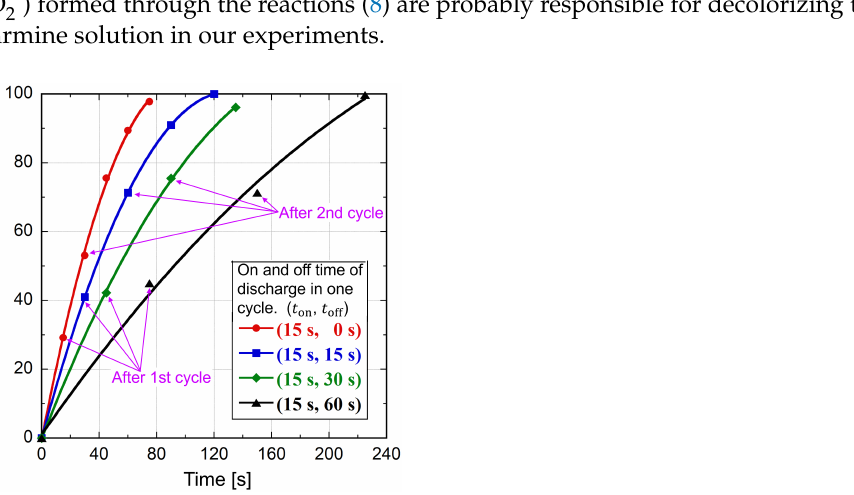
Figure 10. Decolorization rate of indigo carmine as a function of treatment time when intermittent operation was introduced to use post-discharge reactions. t on and t off are defined as the on and off time of the streamer discharges in one cycle, which consisted of turning on the discharge, turning off the discharge, and measuring the absorbance of treatment solution. The 10 mg/L indigo carmine solution was decolorized by the streamer discharges, whose peak voltage and repetition frequency were 21 kV and 100 pps, respectively. The solution was circulated continuously with a flow rate of 1400 mL/min during the